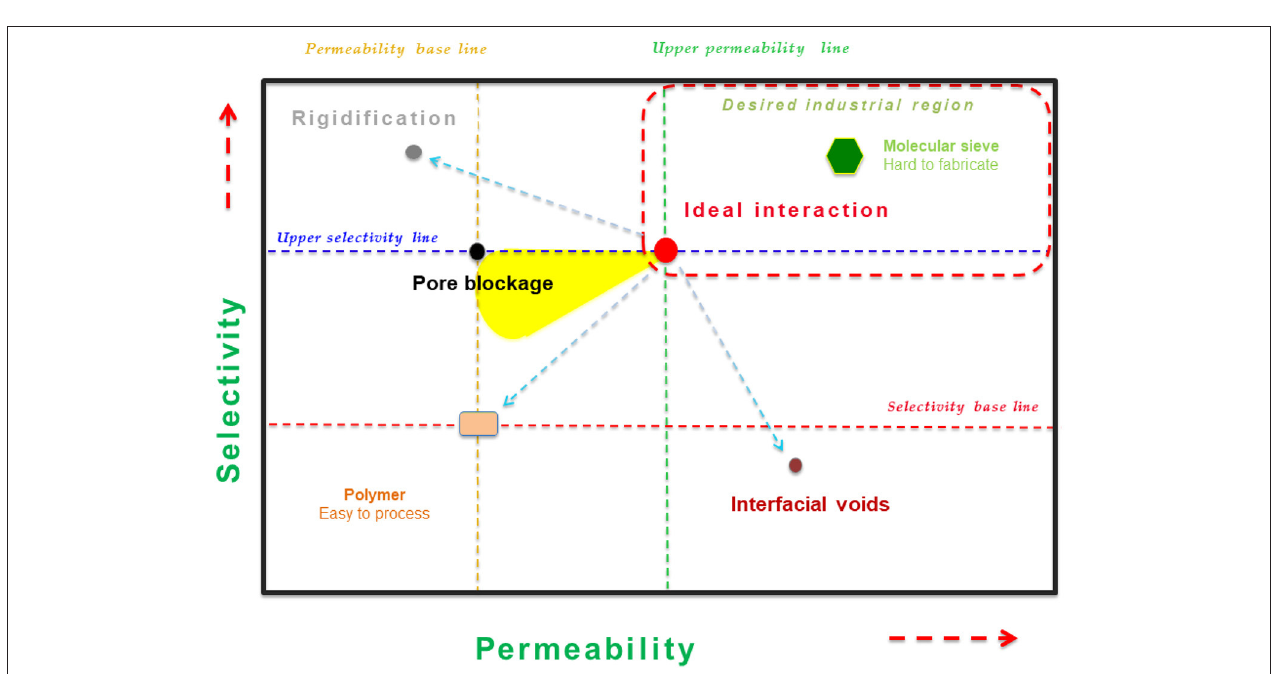
FIGURE 4 | Performance of mixed matrix membranes (MMMs) dependent on the type of morphology at the interface.